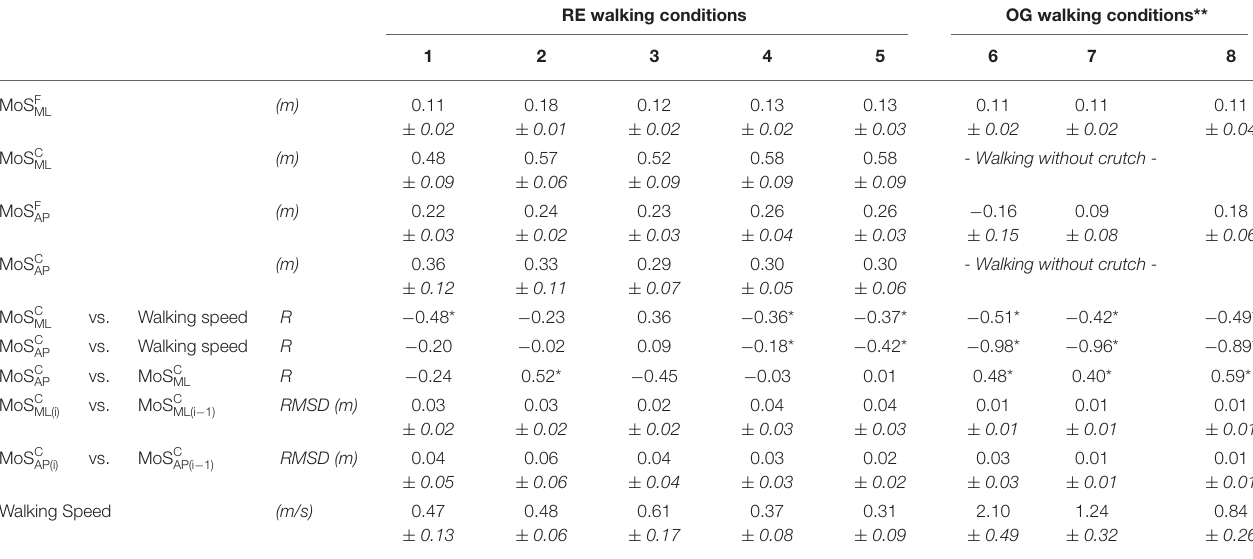
TABLE 3 | Margin of stability (MoS) outcomes across robotic exoskeleton (RE) devices and overground (OG) walk conditions at heel-strike. RE walking